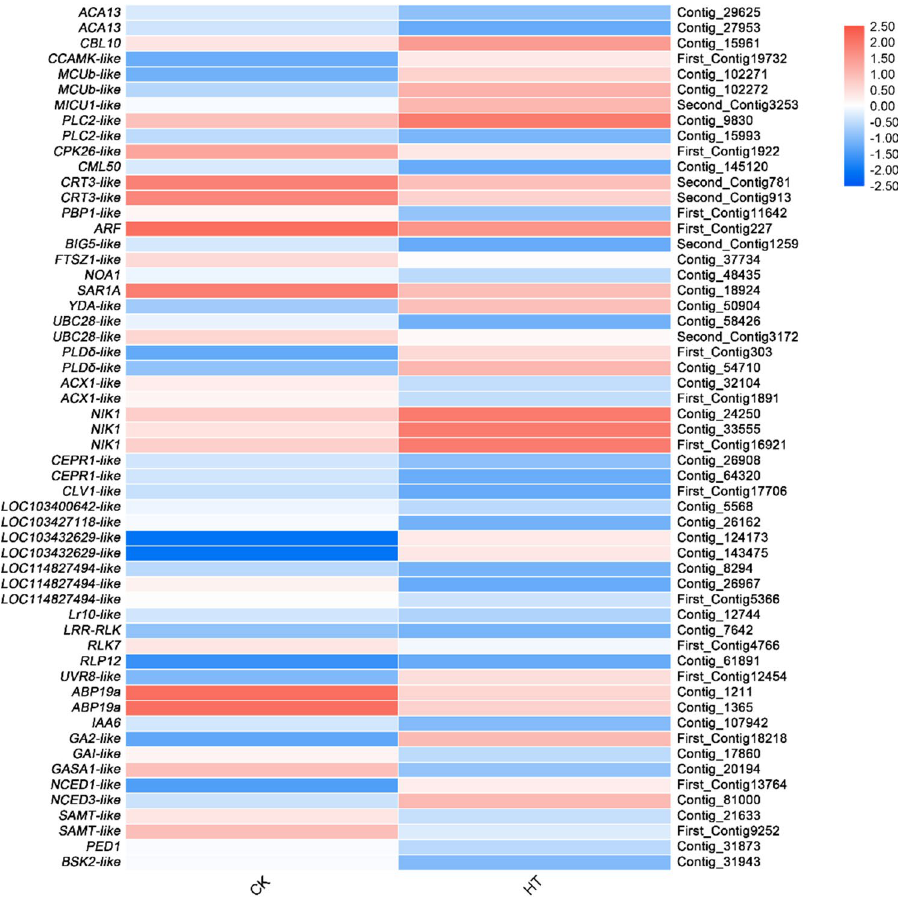
Figure 6. Relative expression levels of DEGs related to signal transduction pathway. The rows in the heat map represent the individual gene IDs, and the columns represent the samples taken from high-temperature treatment (HT) and control (CK). The changes in expression are indicated by colors ranging from blue (down- regulated) to yellow red